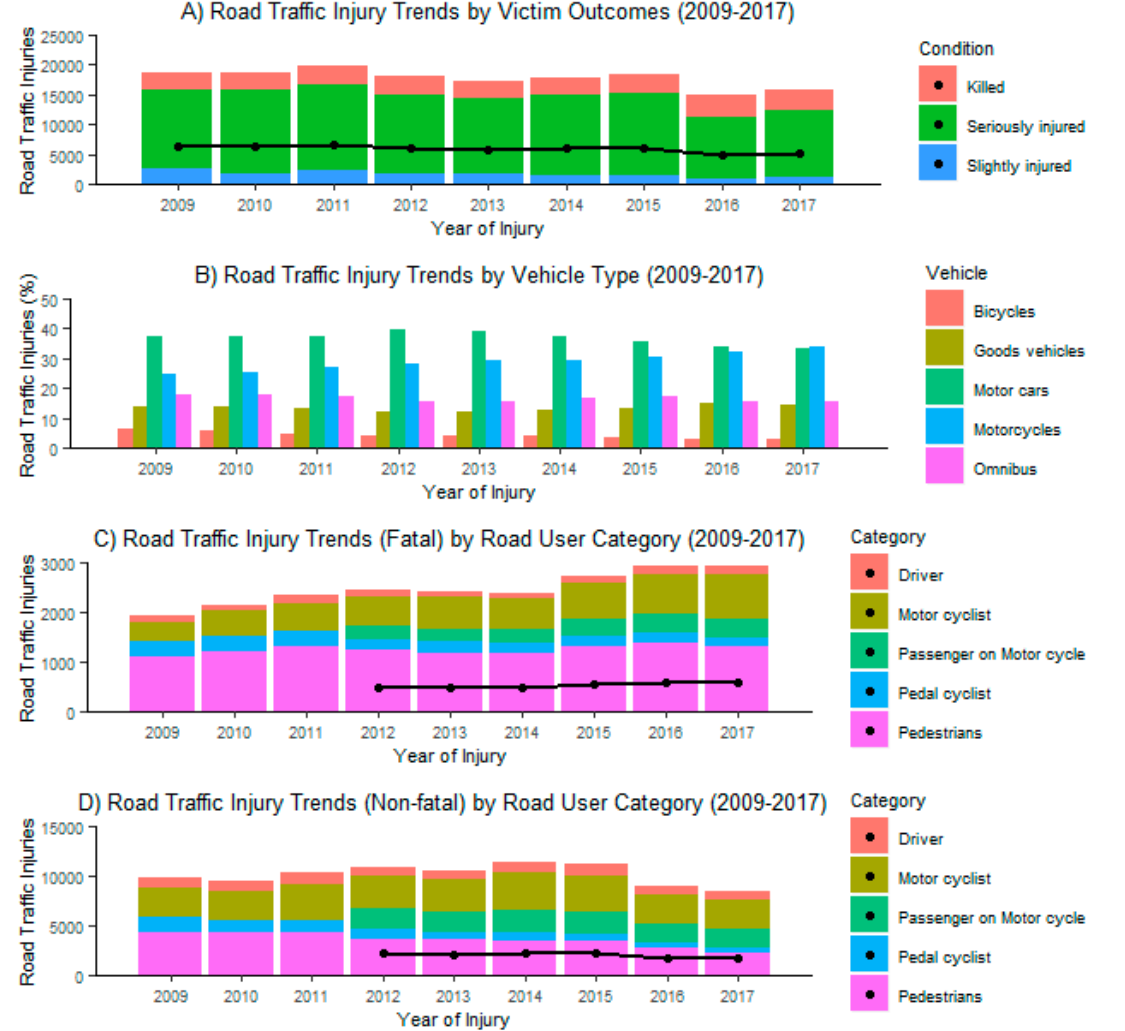
Figure 2. RTI trends from 2009 to 2017. Averages are overlaid as points. For C and D, “Passenger on Motorcycle” category was not available from 2009 to 2011, so averages were not calculated. (A): By victim condition: killed, seriously injuried, or slightly injuried (B): By vehicle type: bicycles,